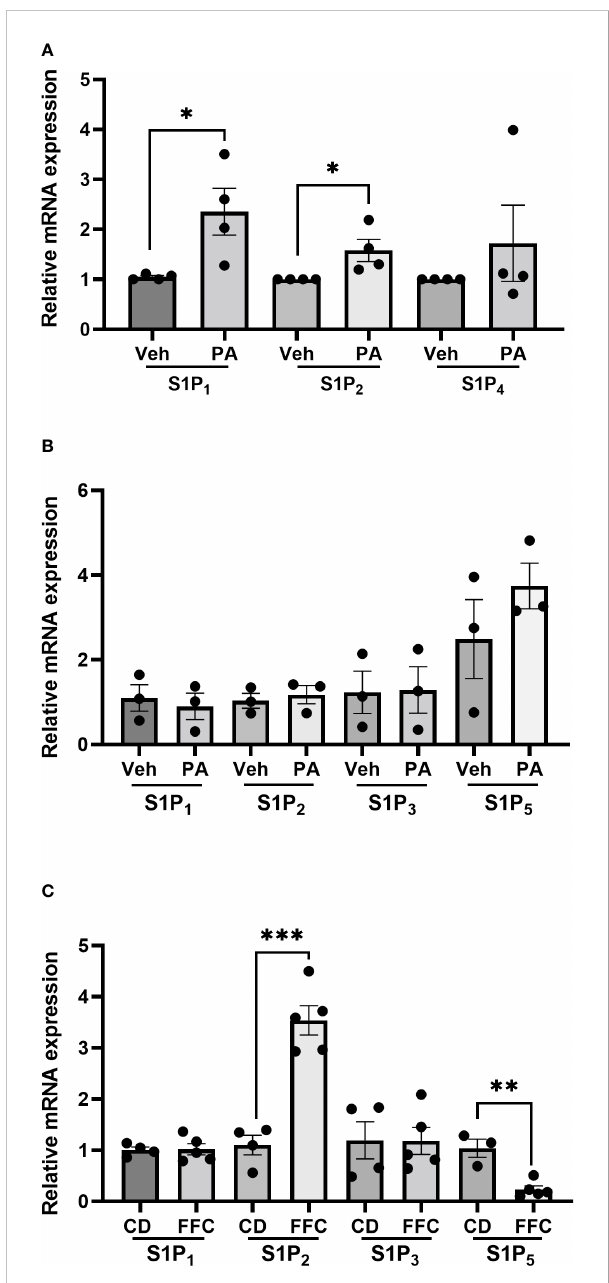
FIGURE 6 S1P 1 and S1P2 are upregulated in palmitate-treated BMDM. (A) In BMDM, expression of S1P 1 and S1P 2 mRNA was induced following palmitate treatment whereas the abundance of S1P 4 remained unchanged (vehicle n=4, palmitate n=4). (B) In PMH, S1P 1 , S1P 2 , S1P 3 and S1P 5 were detected and remained unchanged with palmitate treatment (vehicle n=3, palmitate n=3). (C) In whole livers, S1PR 2 was upregulated, S1PR 5 was downregulated, and no change was noted in S1PR 1 and S1PR 3 in mice fed the FFC diet in comparison to CD fed controls. CD (n=4) and FFC (n=5). *p<0.05, **p<0.01,